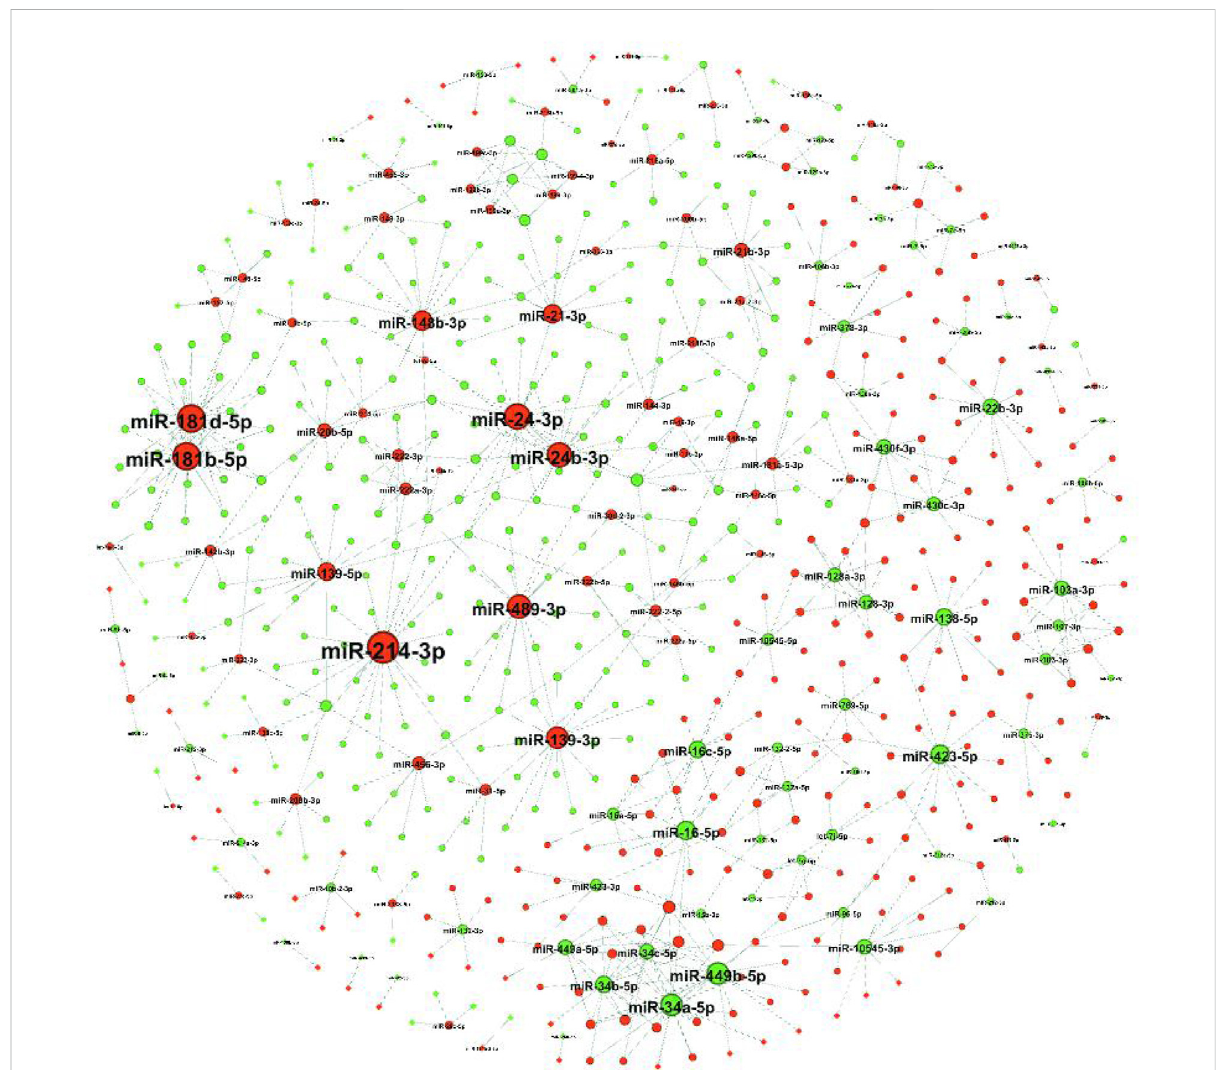
FIGURE 3 Target gene predictions of DE-miRNAs. A regulatory network of DE-miRNAs and their target genes that were negatively regulated. Nodes represent the miRNAs or mRNAs (here only the miRNA symbol is shown). The red and blue nodes represent up- and downregulated RNAs in the ovaries and testis,